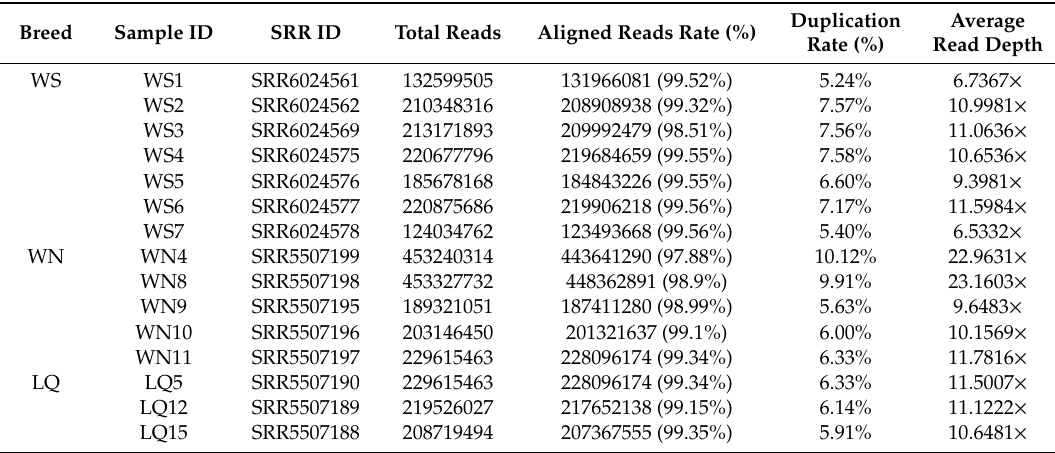
Table 1. Summary of sequencing and mapping results in 15